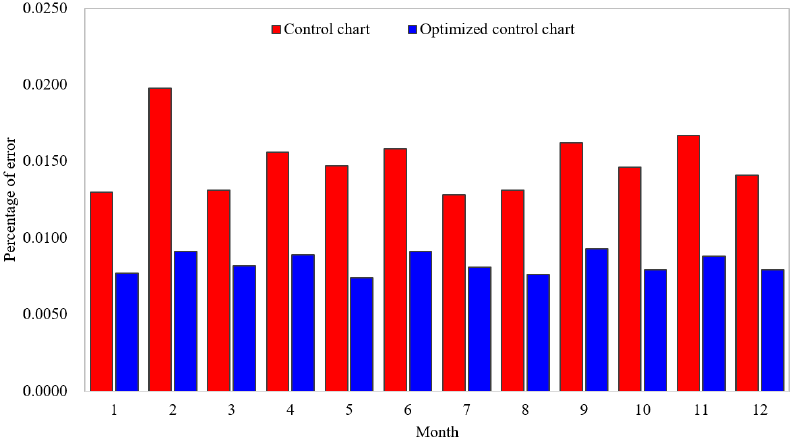
Figure 15. Comparative analysis of error rate of control chart.